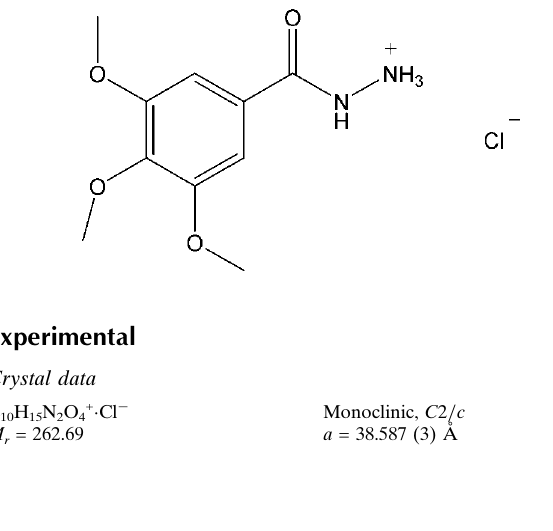
software used to prepare material for publication: CrystalStructure and PLATON (Spek,